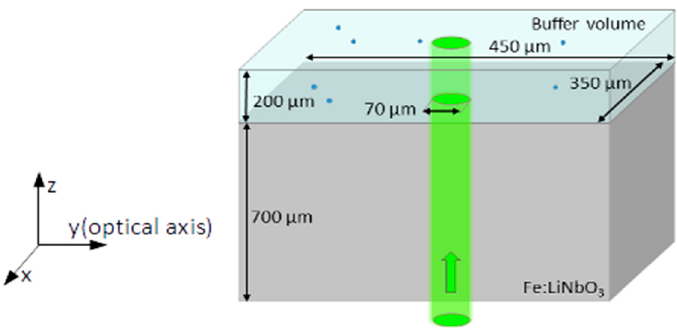
Figure 1. Scheme of the geometry considered for numerical simulation.